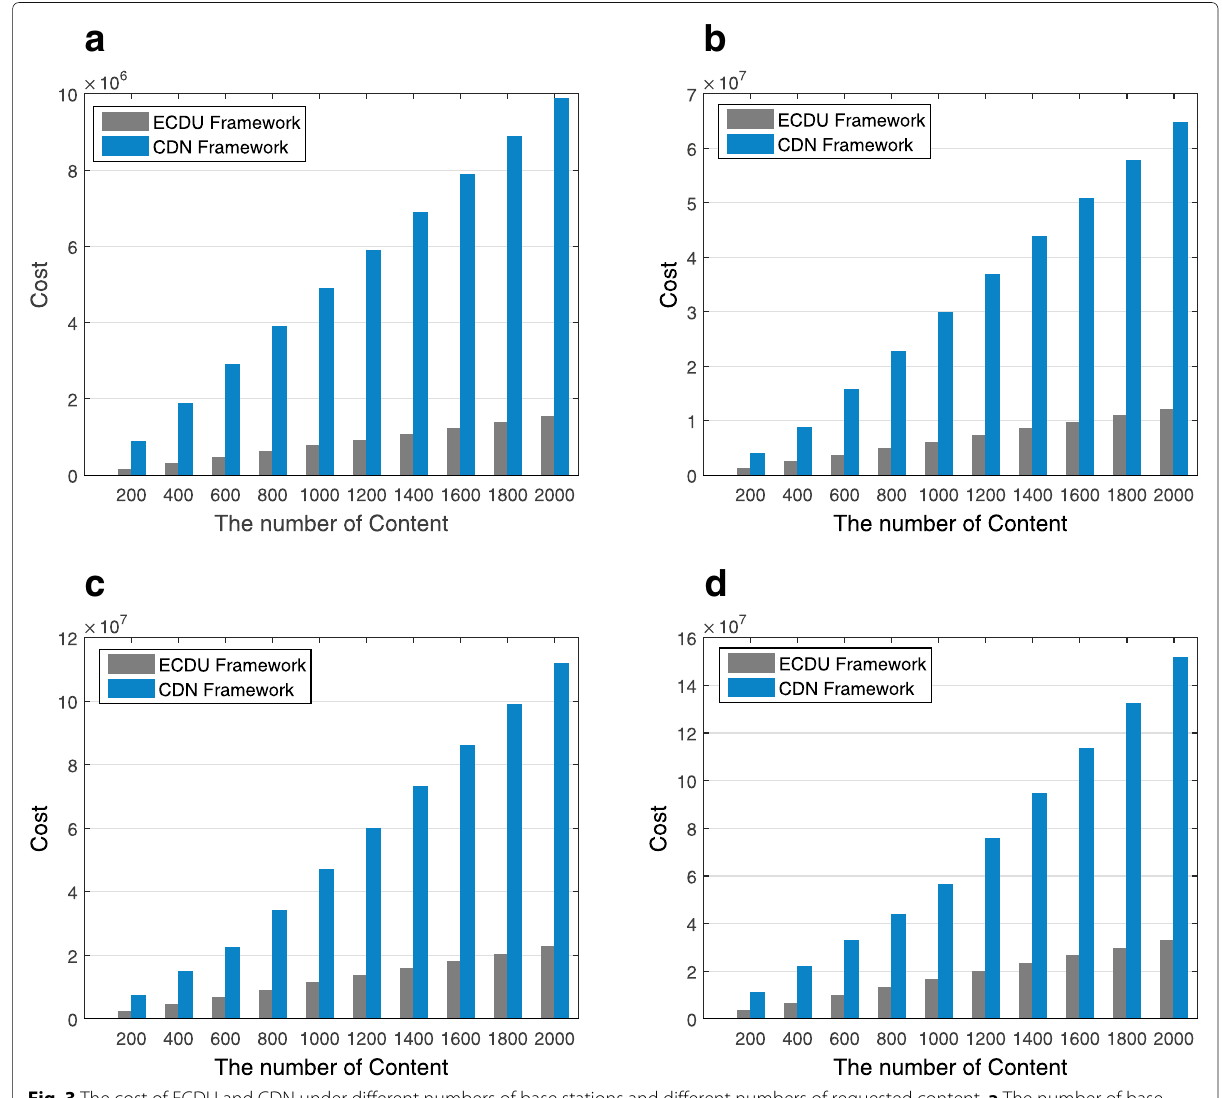
Fig. 3 The cost of ECDU and CDN under different numbers of base stations and different numbers of requested content. a The number of base stations is 5. b The number of base stations is 50. c The number of base stations is 100. d The number of base stations is